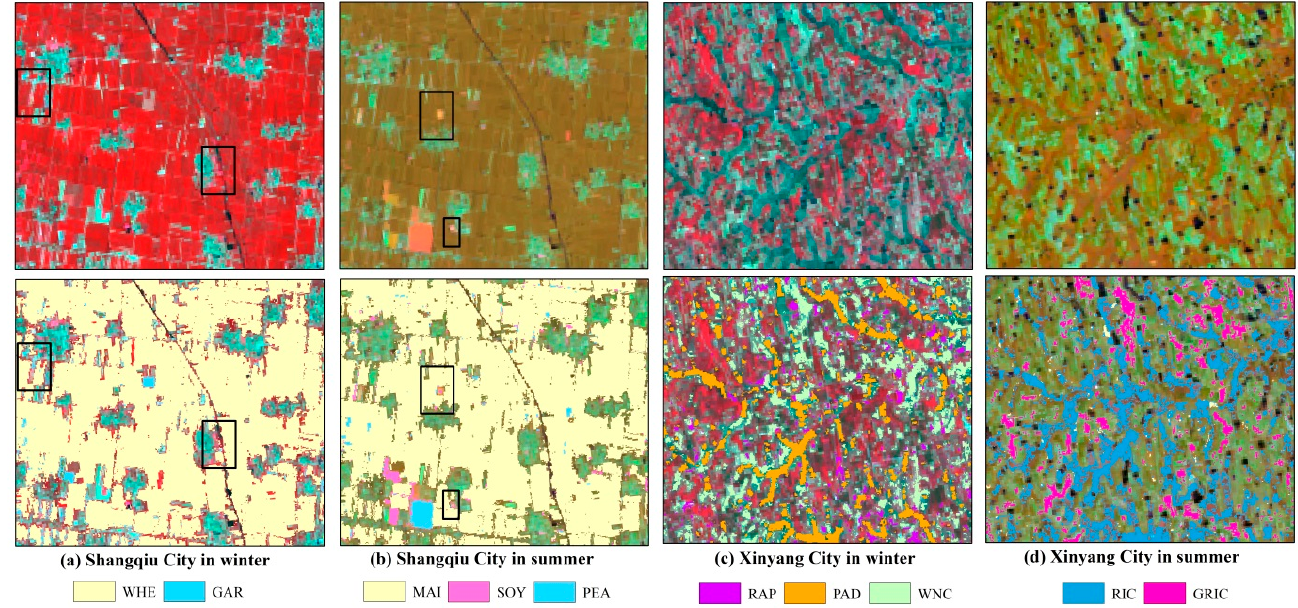
Figure 9. Reclassification of staple and minor crops ( a , b ). Irregular and complex field boundary structures ( c , d ).